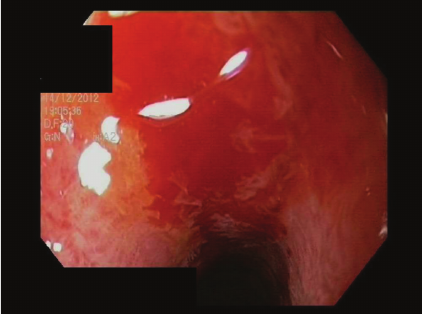
Figure 2: Gastroscopy performed on day 11 and showing diffuse hemorrhagic lesions in the stomach and duodenum, with an ischemic pattern of the mucosa.